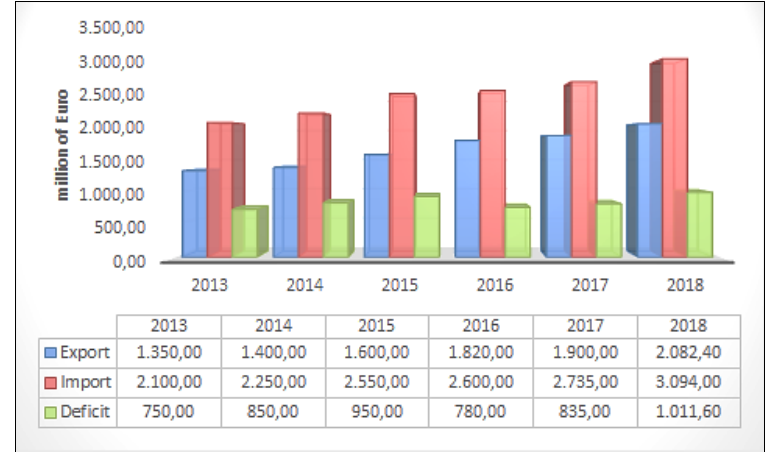
Figure 2. Foreign trade of agri-food products of Croatia in period from year 2013 –